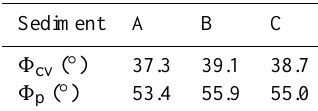
Table 2. Constant volume 8 cv (measured using a tilting table cov- ered by fixed grains of the same size) and peak friction angle 8 p (measured for specimens with relative density DR=25).